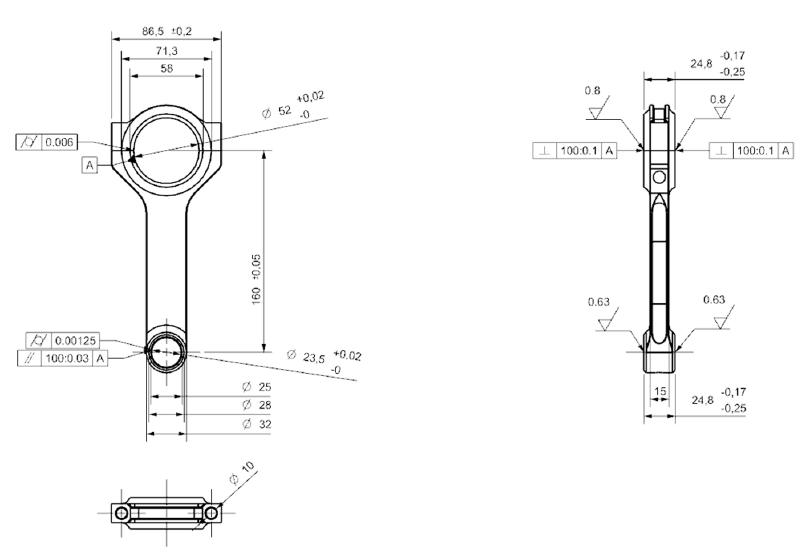
Figure 2. The three orthographic views of the Automobile connecting rod.